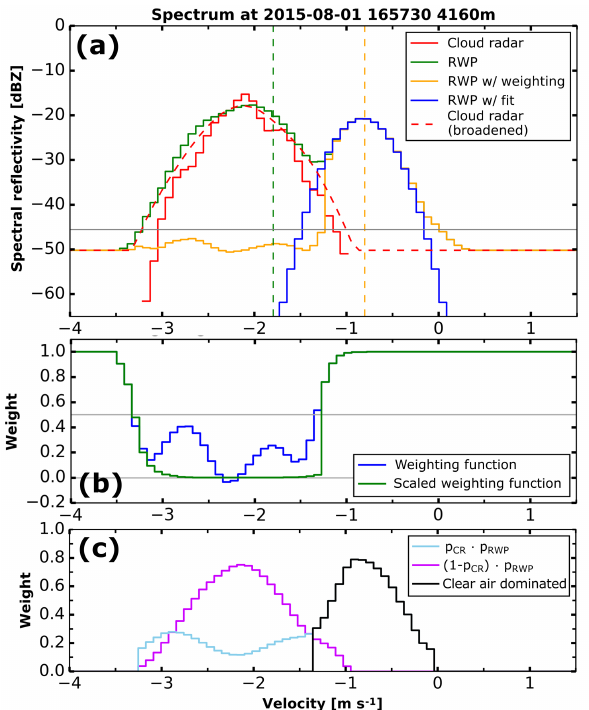
Figure 6. Doppler spectrum for 1 August 2015 16:57UTC at 4160m (a) , the associated weighting function (b) and the fuzzy membership function (c)